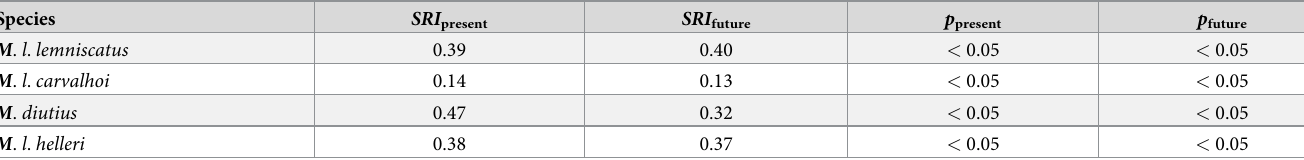
Table 4. Species representation index ( SRI ) and p -values from